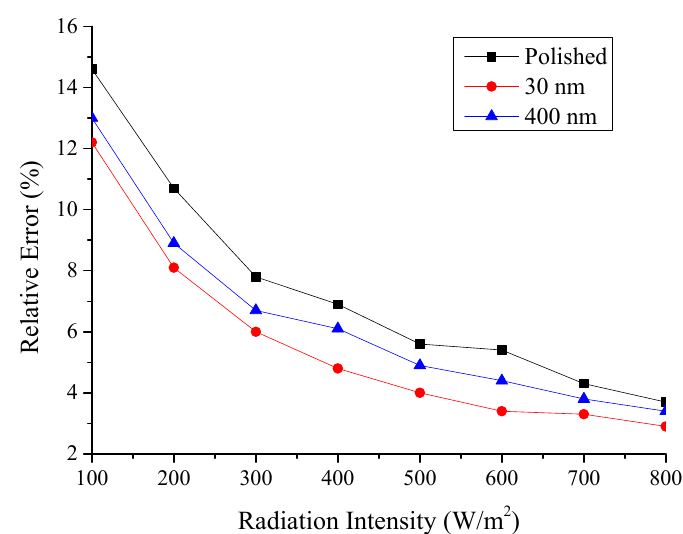
Figure 23. Relative error of the testing absorptivity with radiation intensity for the three testing rigs.